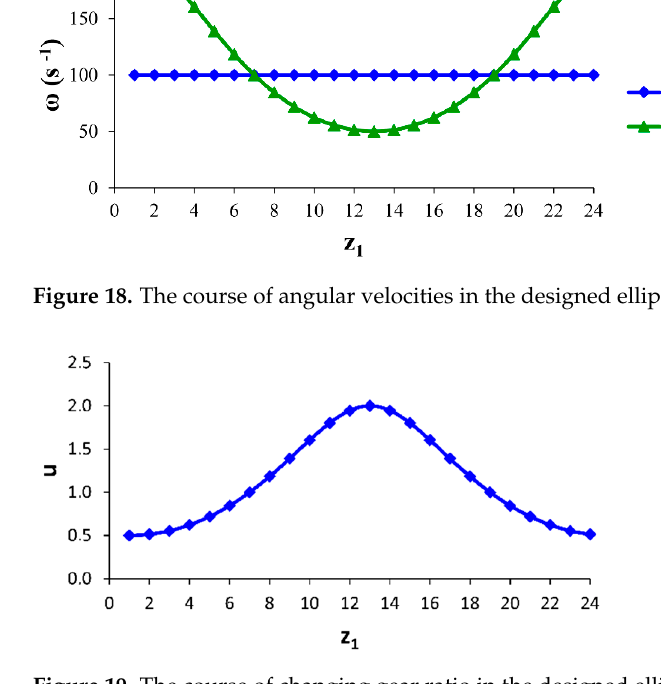
Figure 20. Defining the angle of rotation of the driving gear. Figure 21. The course of the gear ratio dependent on the angle of rotation of the driving gear. Figure 22 shows the length of part of contact of tooth number 24 of the driving wheel with tooth number 12 of the driven wheel. The point A is the first point of meshing of